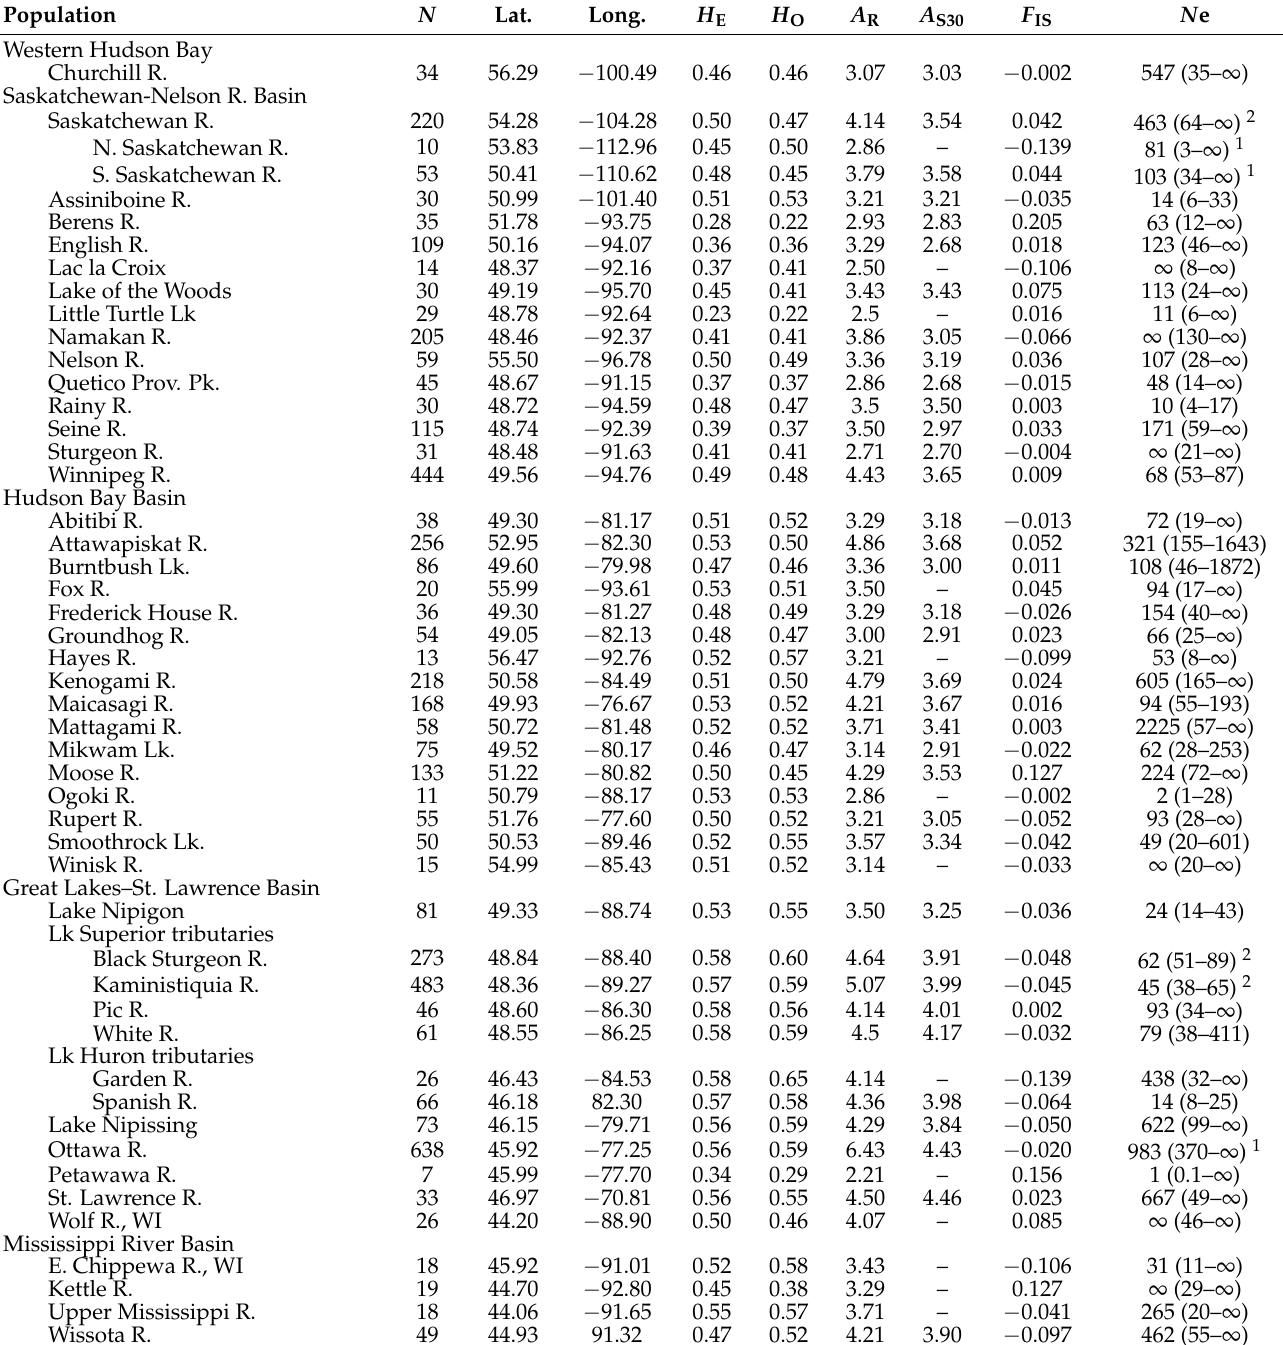
Table 1. Summary of sampling locations by secondary watershed basins, showing sampled popula- tions/waterbodies, sample sizes, geographic coordinates (latitude and longitude as decimal degrees), expected and observed heterozygosity ( H E and H O , respectively), absolute and standardized allelic richness ( A R and A S30 , respectively), F IS , and estimated genetic effective population sizes ( N e ) using a minimum allele frequency of 0.05. N e superscripts indicate published N e estimates from 1 [22], 2